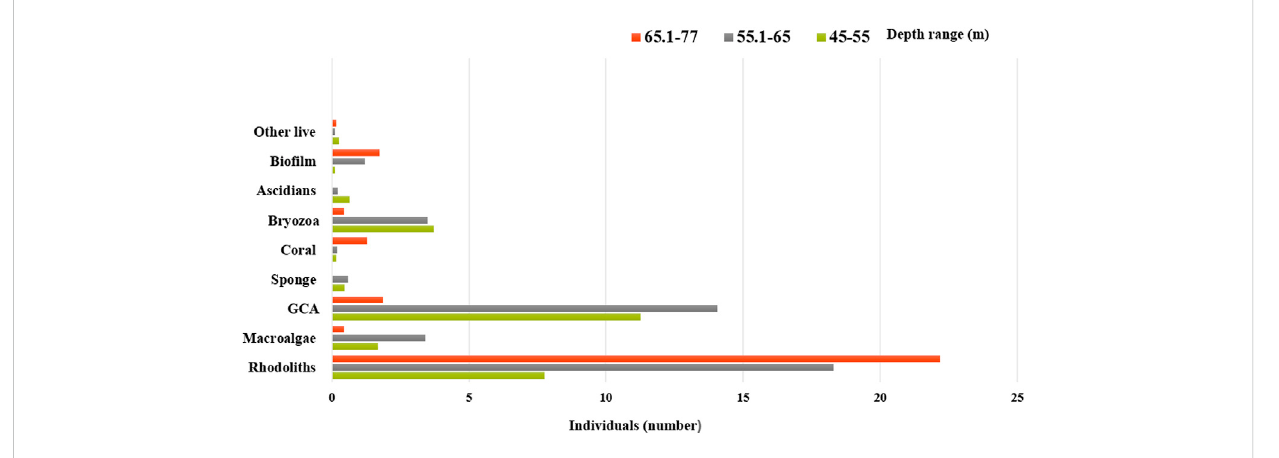
FIGURE 6 Organisms ’ distribution by depth range along the study area.